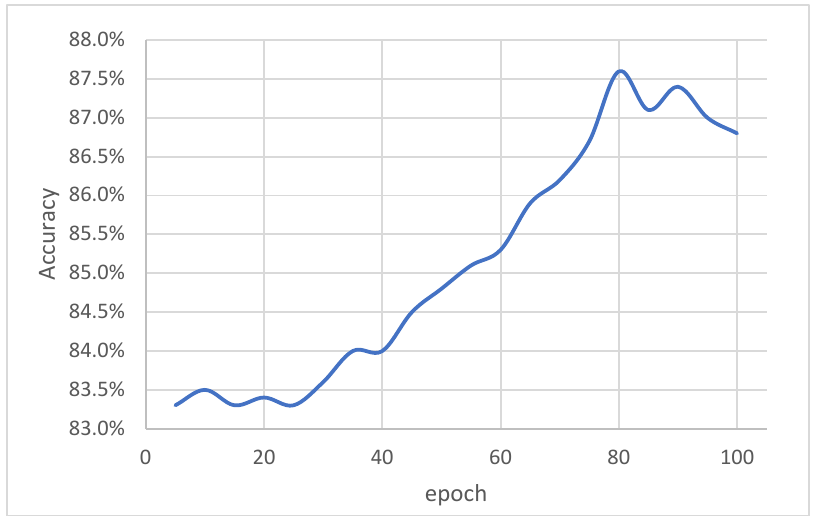
Figure 2. Accuracy of the proposed multimodal model for Task 1. Table 11. Confusion matrix of the three models on Task 1. Inf represents informative. Not-Inf rep- resents not informative.